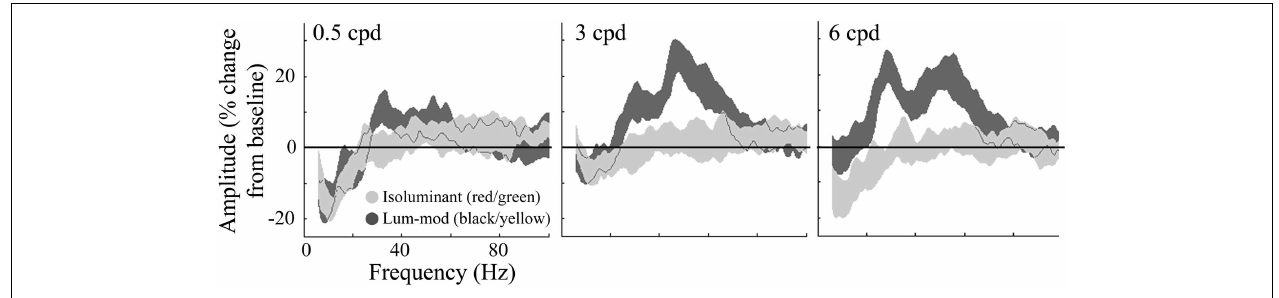
across all participants.The amplitude spectra, plotted as percentage change from the pre-stimulus baseline, are shown for each of the stimulus spatial frequencies. Note the increases in amplitude to luminance-modulated gratings occurred with two peaks, one at approximately 30 and another at approximately 50Hz.